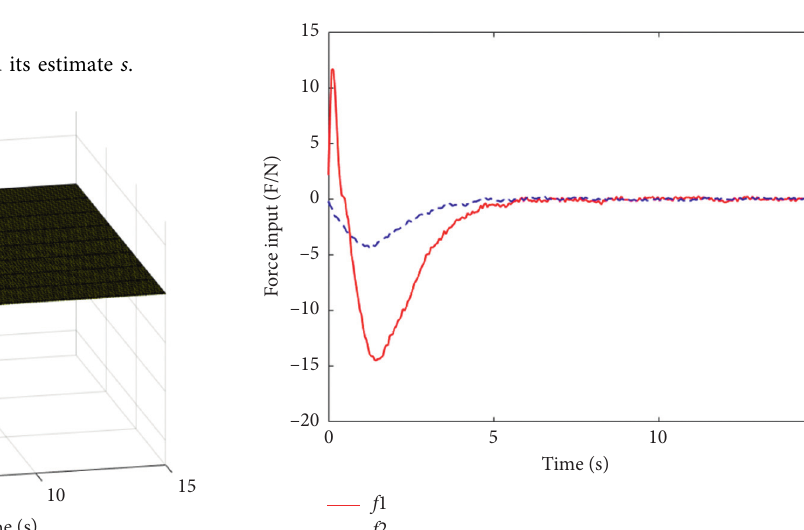
Figure 7: Torque inputs of two joints.